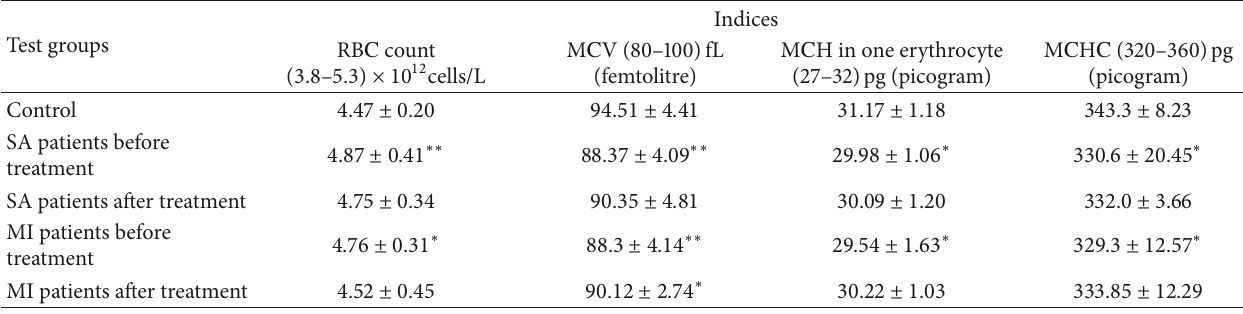
Table 1: RBC count and erythrocyte indices in the blood of apparently healthy people and in patients with SA and MI before and after treatment, 𝑛 = 20 ( V ± SD).